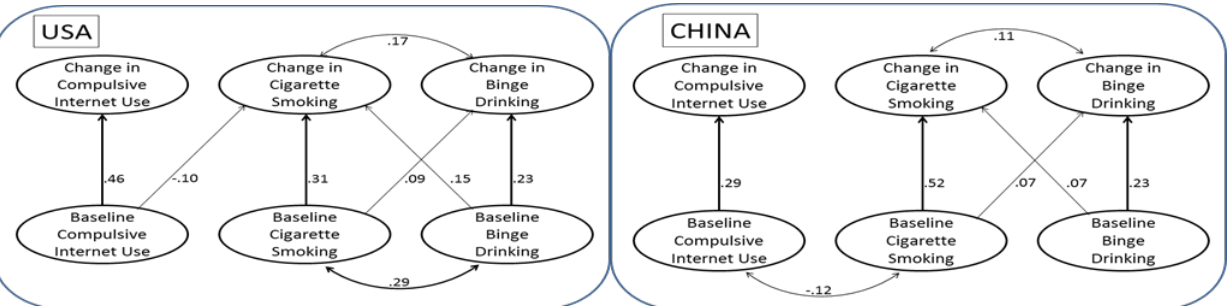
Figure 2. Male students only: Concurrent and longitudinal predictive relationships among CIU, cigarette smoking, and binge